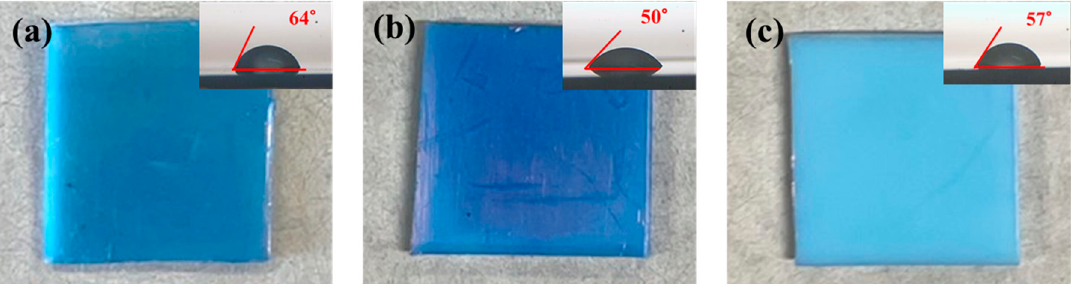
Figure 11. Photographs of dye staining and water contact angles of ( a ) untreated, ( b ) acidic treat-ed, and ( c ) alkali treated Au-W-13F-P